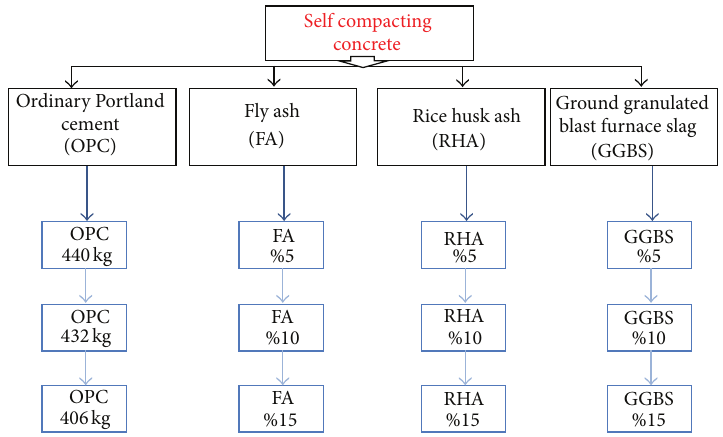
Figure 1: Mix proportions of various mixes. Table 3: Selected mix proportion of SCC with various supplementary material